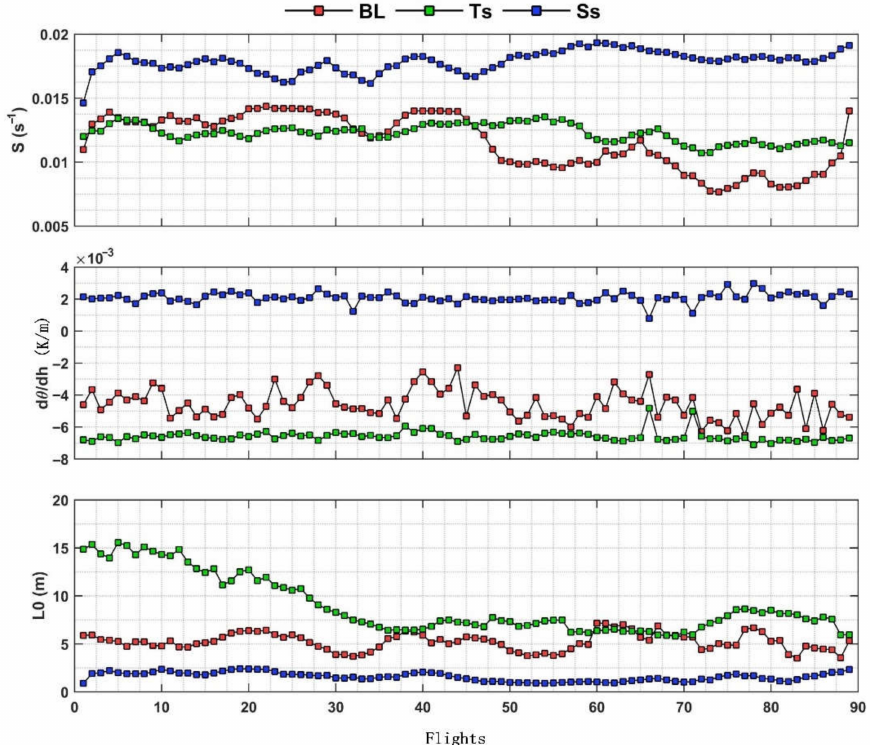
Figure 6. Statistically average turbulence parameters in different atmospheric layers. BL: boundary layer; Ts: troposphere; Ss: